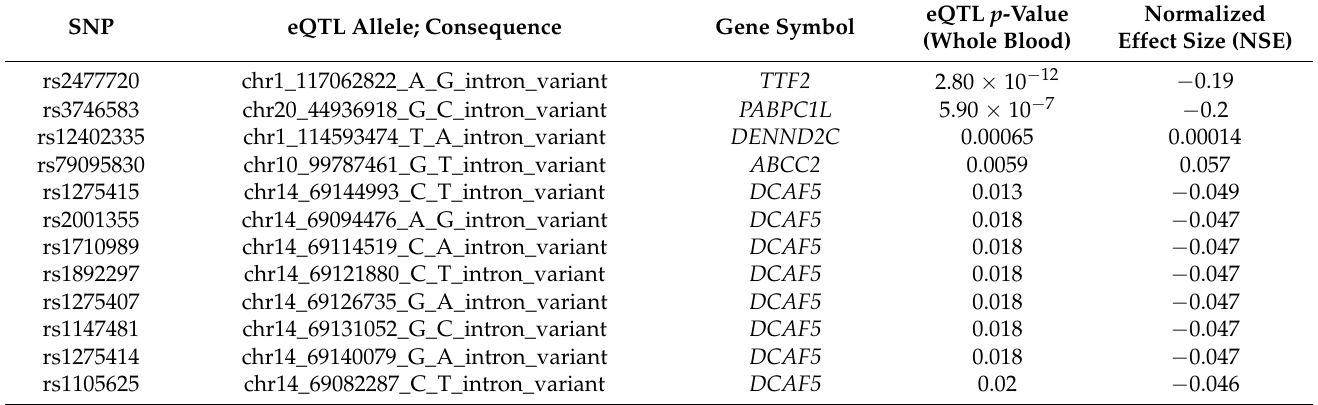
Table 3. Annotation of quantitative trait loci (eQTLs). Abbreviations : GTEx, The